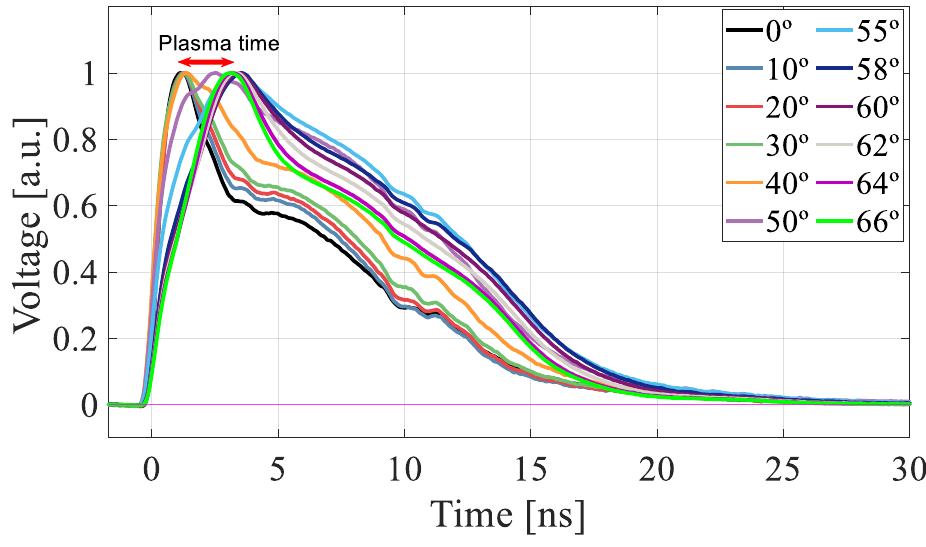
Figure 19. TRIBIC waveforms at 45 V for angles up to 66°.